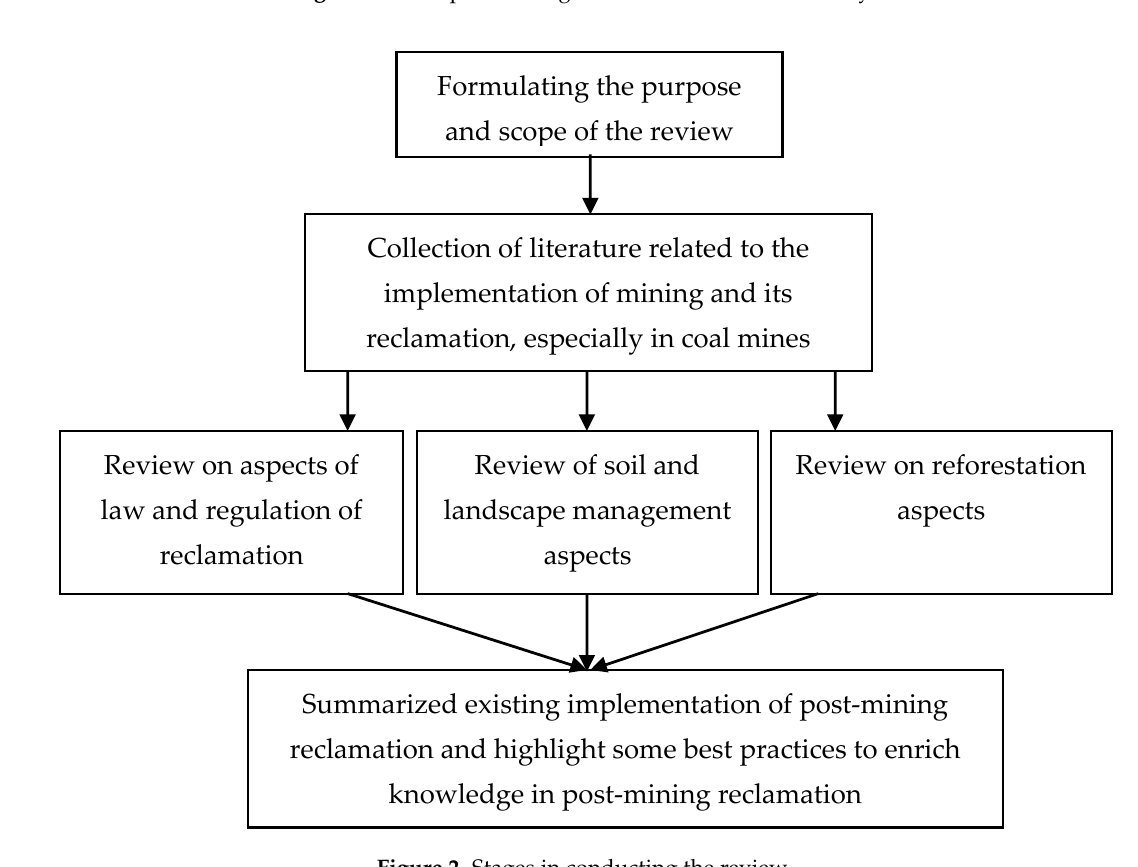
Figure 2. Stages in conducting the review.